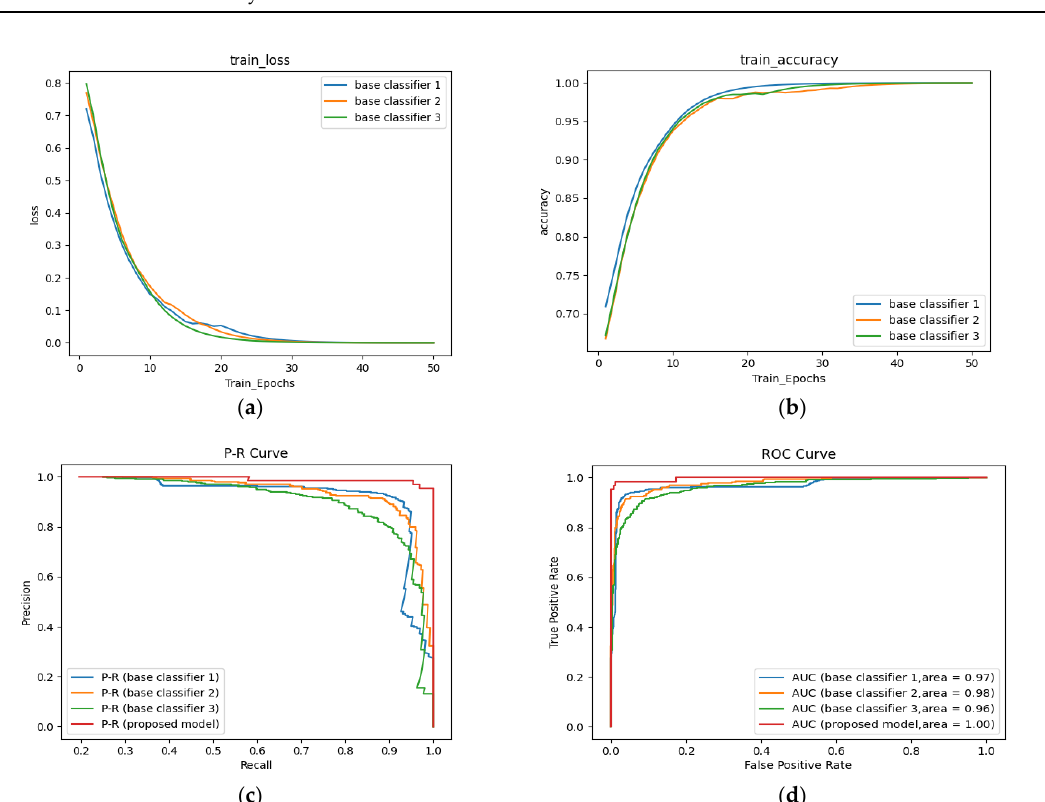
Figure 8. Four-class correlation curves for the three base classifiers and the proposed model (COVIDX-LwNet). ( a ) train loss, ( b ) train accuracy, ( c ) P-R, ( d ) ROC.